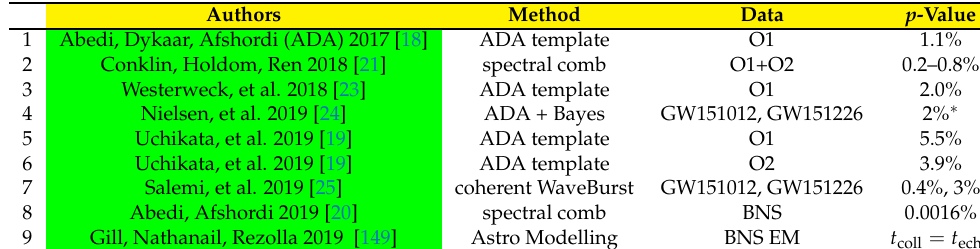
Table 3. Table of positive results ( p -value is a rough estimate, based on the log-Bayes = 1.66).